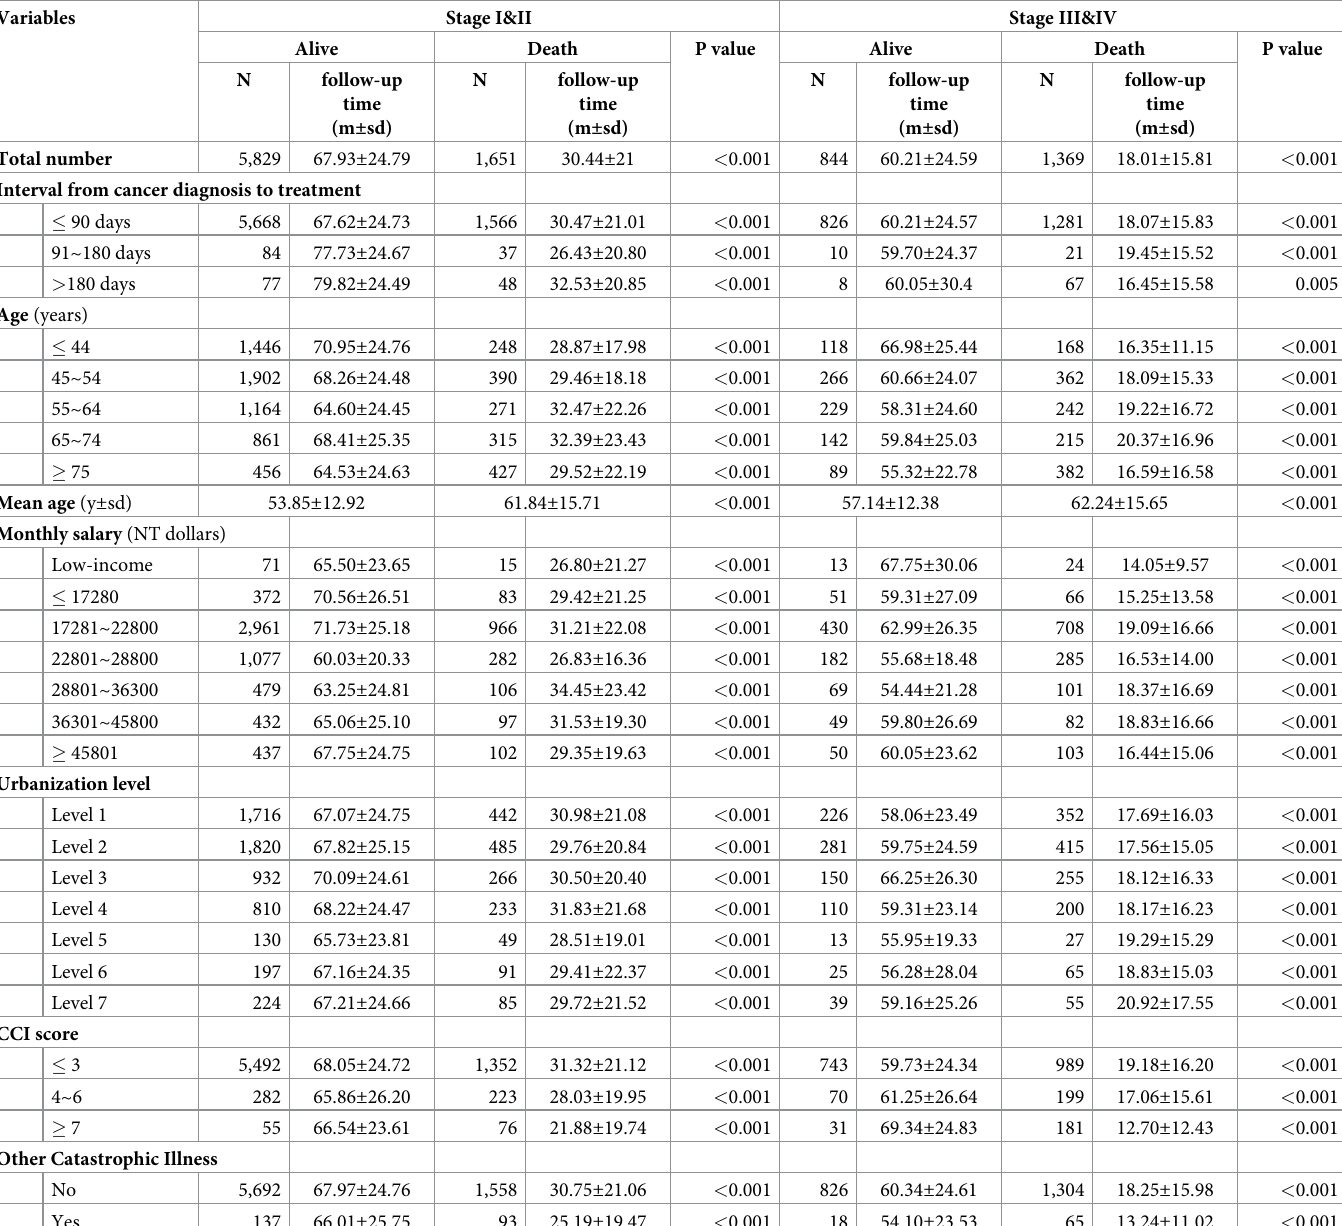
Table 3. Average follow-up time or survival time (months) for the cervical cancer